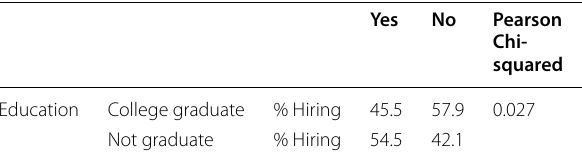
Table 4 Cross-tabulation regarding education background